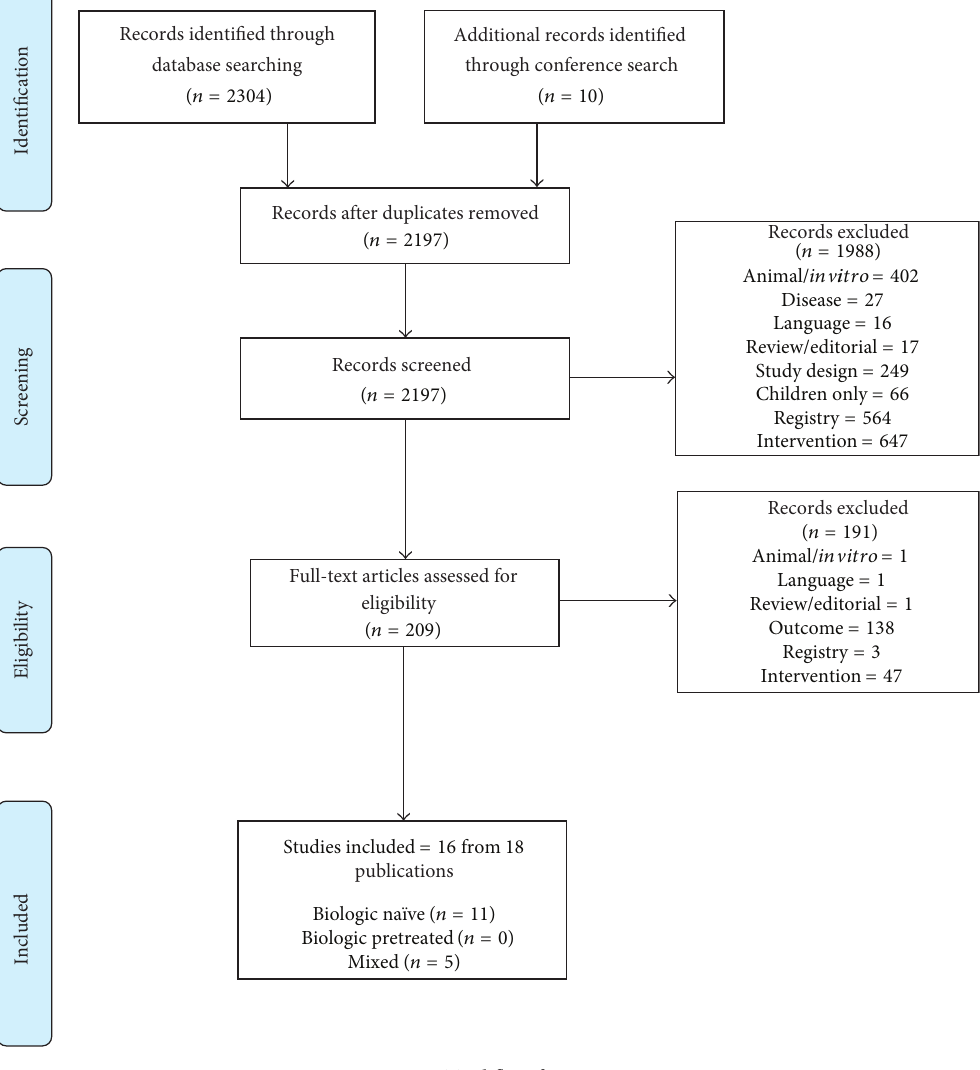
Figure 1: Trial flow for paper.